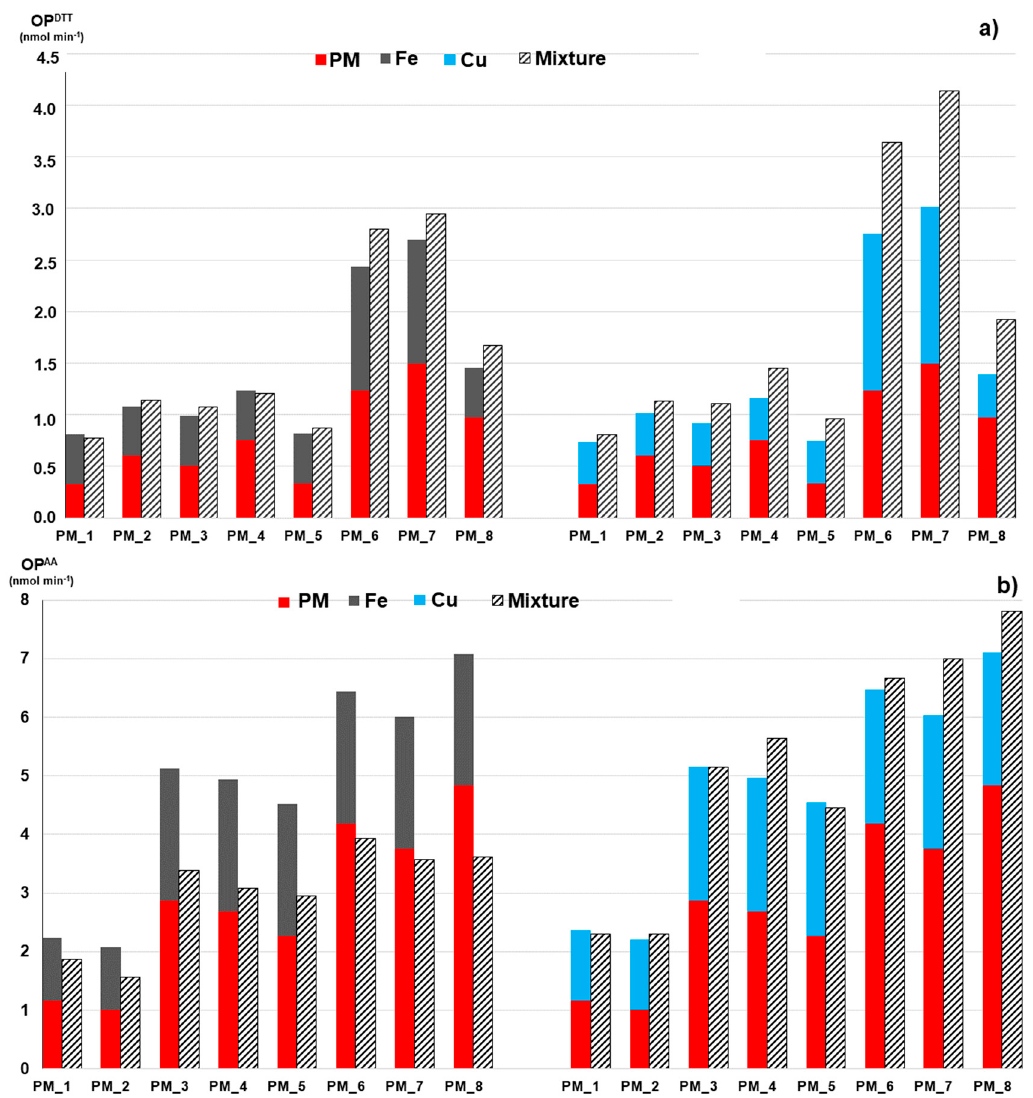
Figure 2. DTT consumption OP DTT ( a ) and AA consumption OP AA ( b ) activities of the real-world PM 2.5 samples. The bottom red bars indicate OP of each individual PM extract, the top bars are OP of the standard solutions of Fe and Cu added to the extract (grey: Fe, light blue: Cu), while the staked bars show OP experimentally measured on their combinations. OP is expressed as nmol min − 1 . The concentrations of the added Fe and Cu solutions are reported in Table 4. Table 4. Interaction factors for DTT and AA consumption in the real-world PM 2.5 samples after ad- dition of standard solutions of Cu and Fe metals and of PQN and NPQ quinones.